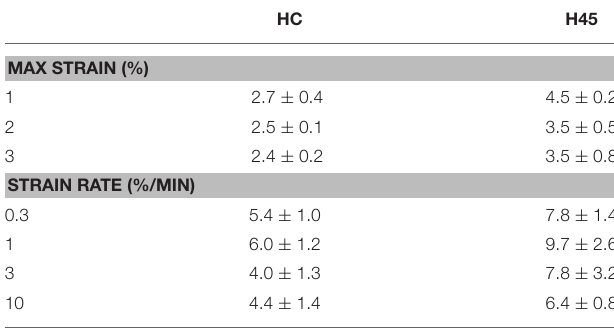
TABLE 2 | Gauge factor (K) of ABS/CNT 3D-printed samples produced in HC and H45 configuration.